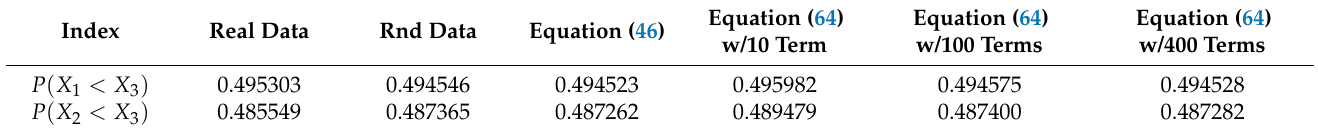
Table 4. Reliability Measures P ( Y < X )